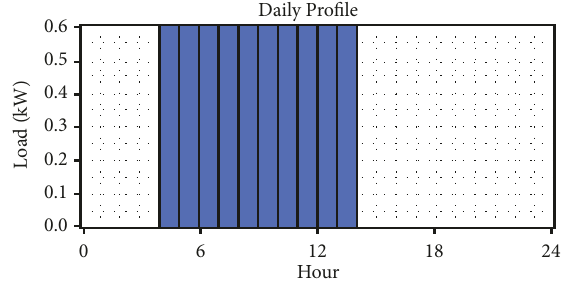
Figure 7: The load for the DC motor in HOMER. Table 1: Hydrogen storage system for SE and ED. Hydrogen